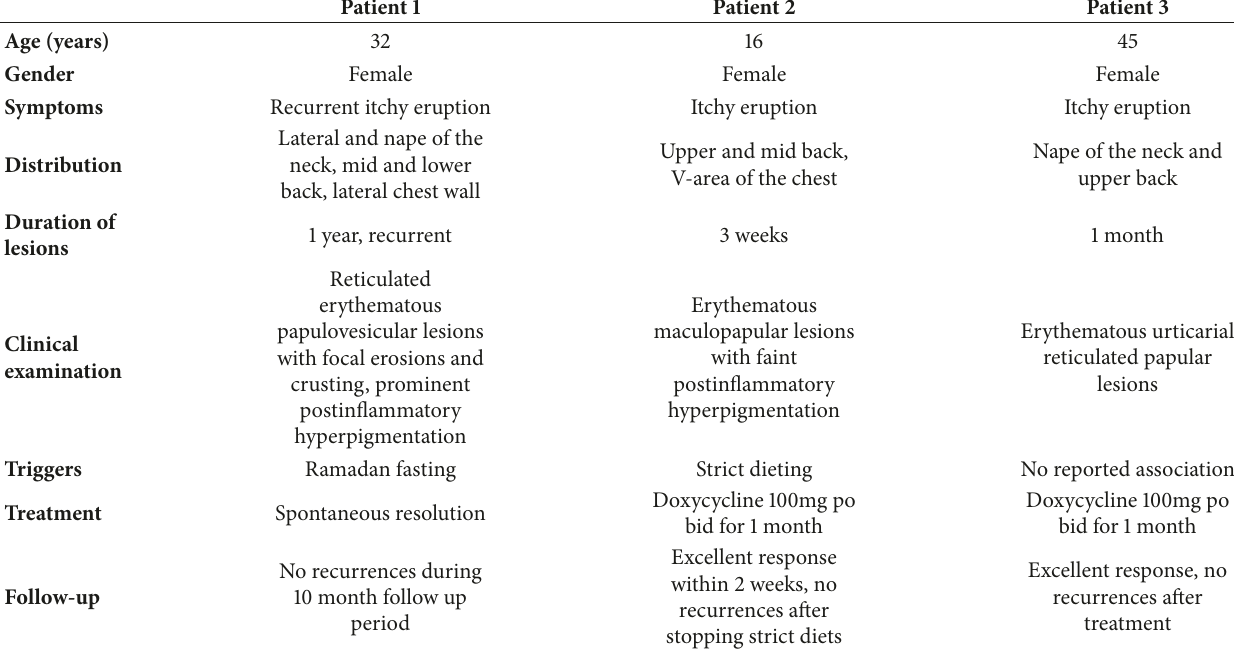
Table 1: Demographics, clinical features, and outcomes of 3 Jordanian patients with prurigo